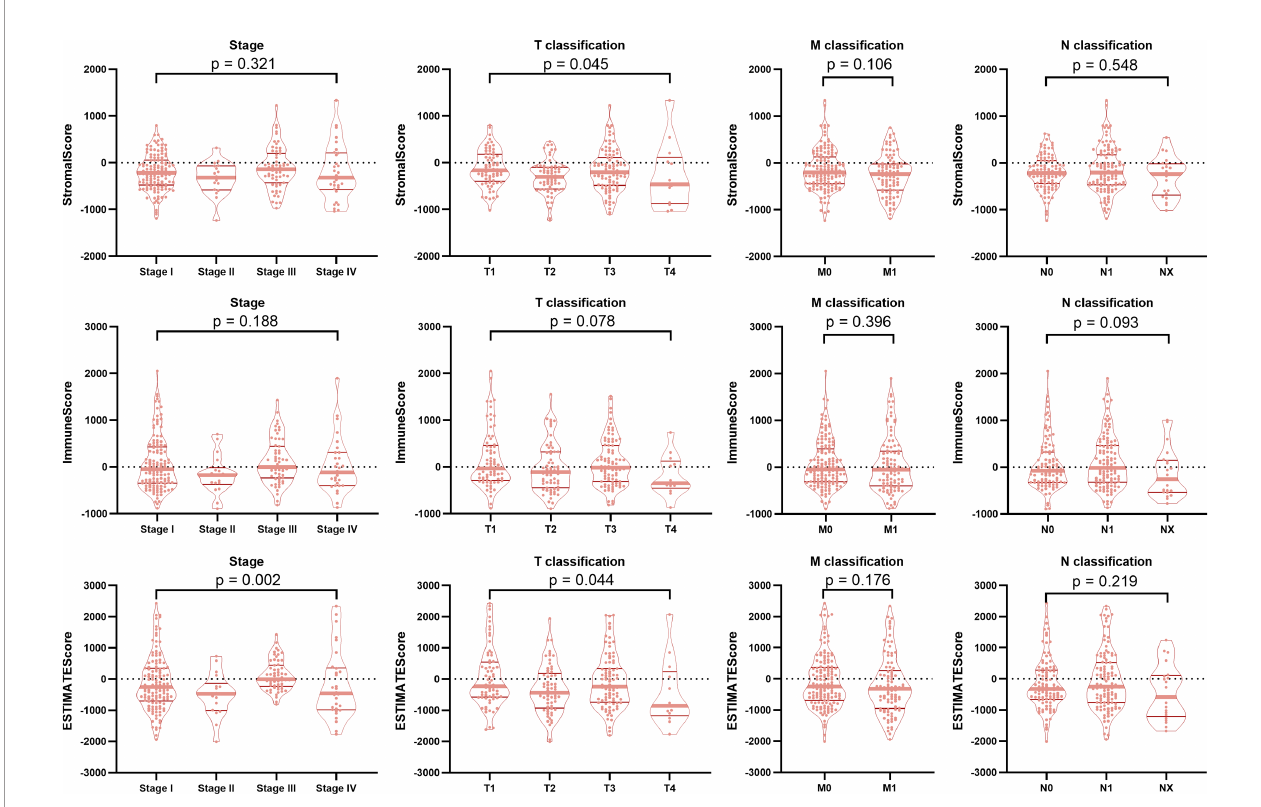
FIGURE 2 | Correlation of TIME scores with clinicopathological staging characteristics. The StromalScore was correlated with the T classi fi cation of the TNM staging system ( p = 0.045), and the ESTIMATEScore was signi fi cantly associated with the stage ( p = 0.002) and T classi fi cation ( p = 0.044). ImmuneScore had no correlation with the tumor stage or the T classi fi cation, M classi fi cation, or N classi fi cation of the TMN staging system (all p > 0.05).